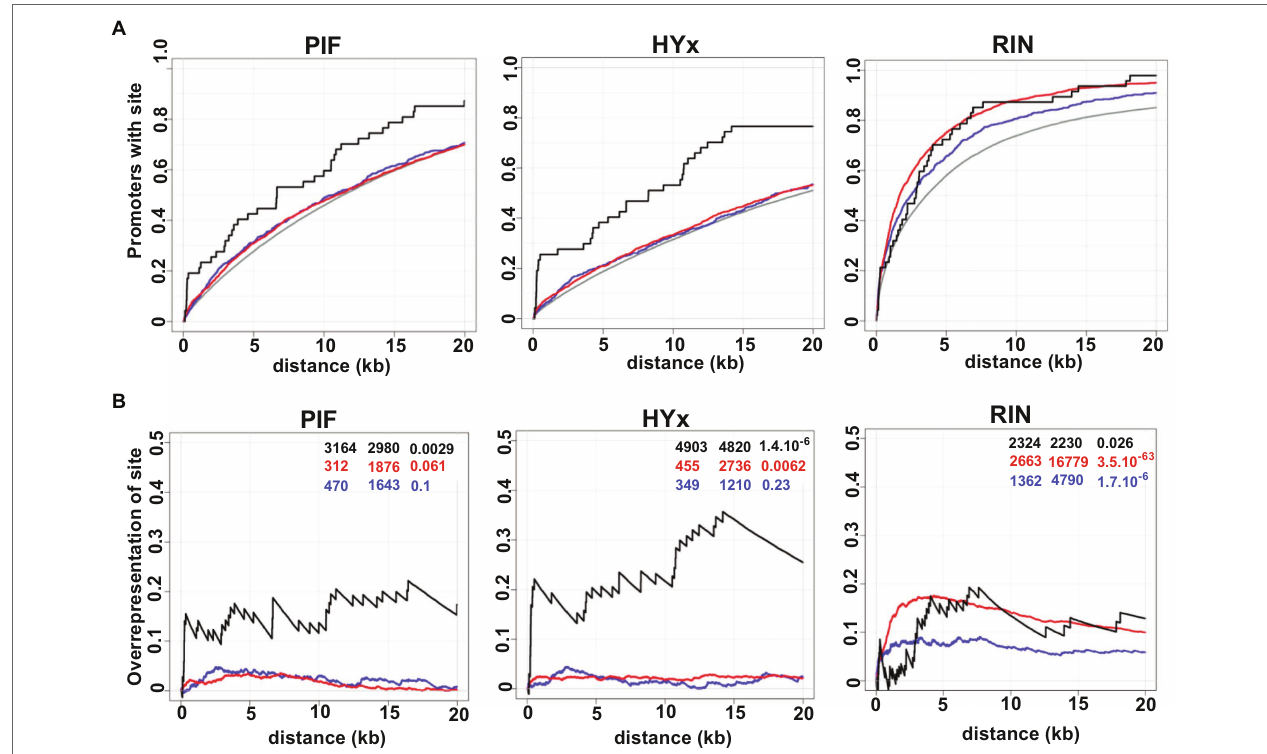
FIGURE 6 | Positional distribution and enrichment of TF binding sites on PHYB1B2 regulated genes. The three gene dataset analyzed were: upregulated (red), downregulated (blue) and chromatin-remodeling (black) DEGs in phyB1B2 at breaker stage. (A) Additive gene fraction harboring the indicated element in comparison with randomly chosen gene set (grey). (B) Over-representation of elements in the regulated genes in comparison to the randomly chosen gene set by subtracting the curves shown in (A) . The enrichment score, z -score and p -value for each class of TF are shown from left to right as inset. PIF includes PHYTOCHROME INTERACTING FACTOR 1,3,4,5 and 7 sites; HYx includes ELONGATED HYPOCOTYL 5 (HY5) and HY5 HOMOLOG (HYH) from Jaspar Database; RIN sites are based in the peak calling of ChIP-seq data (Zhong et al., 2013). X axis indicates upstream distance from the transcription start site